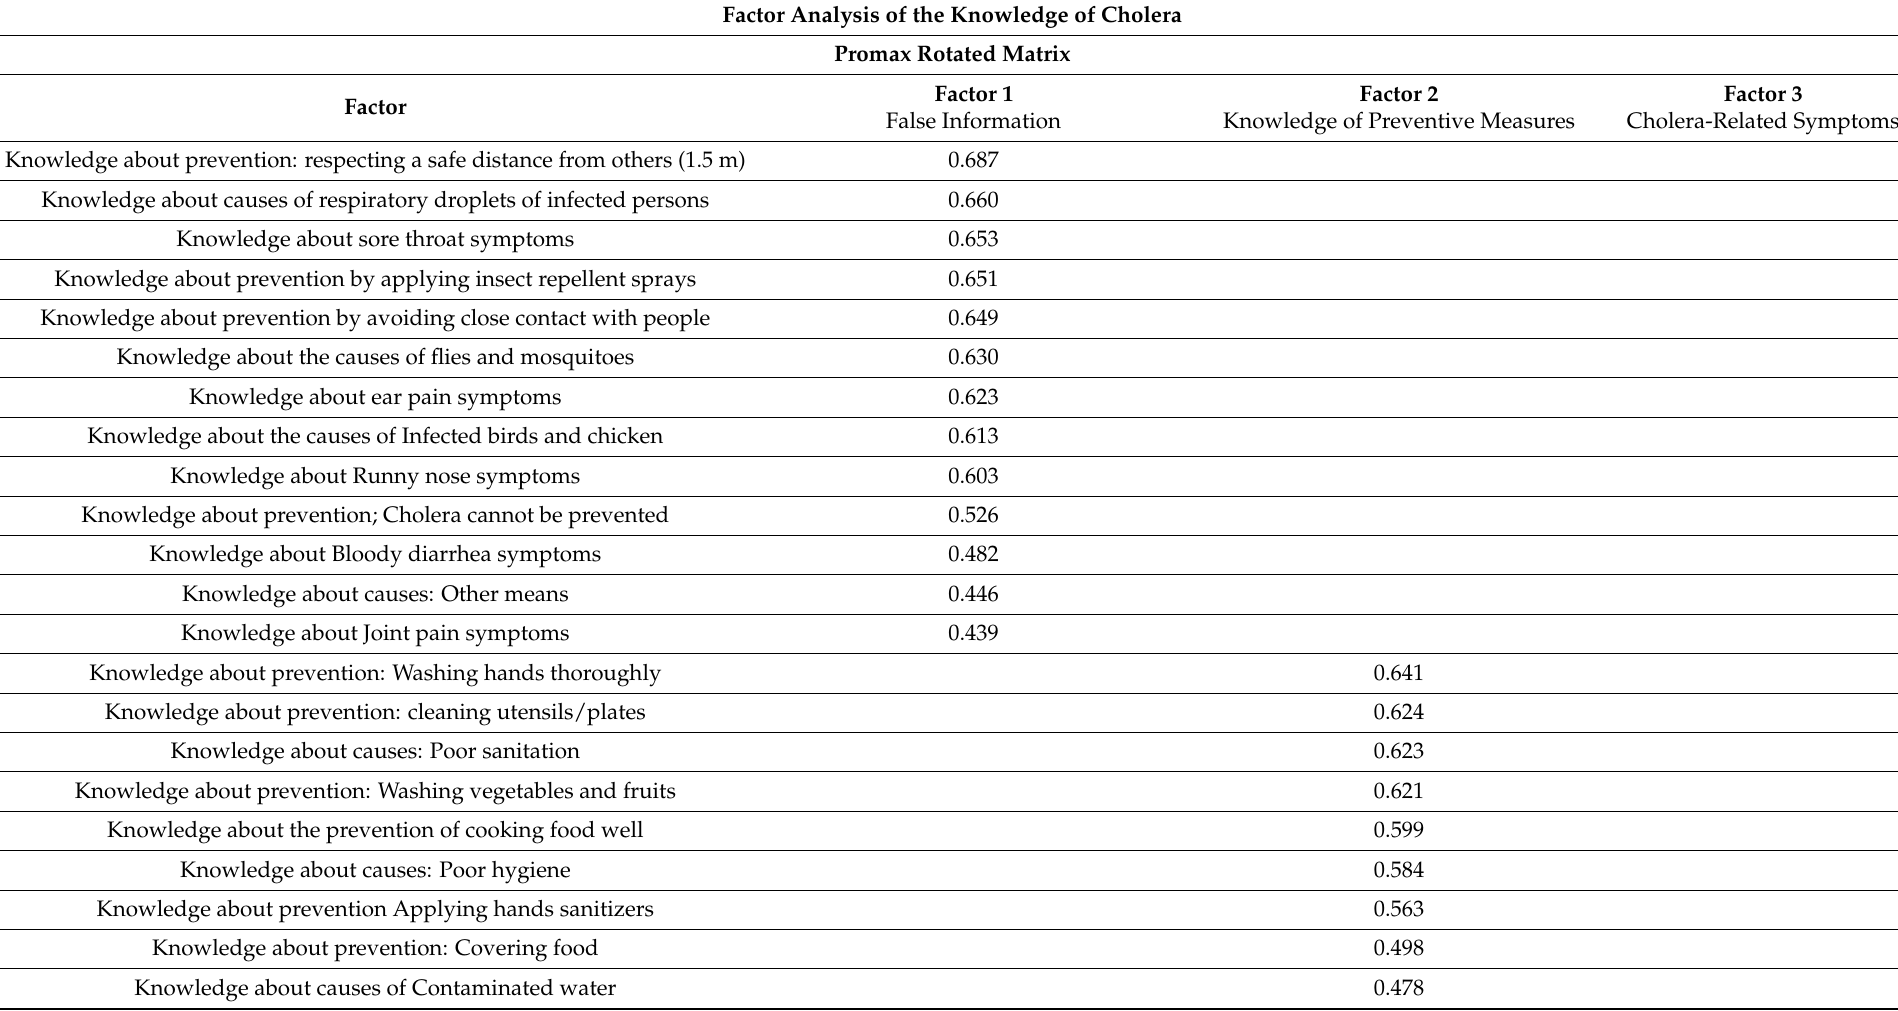
Table 2. Factor analysis of KAP